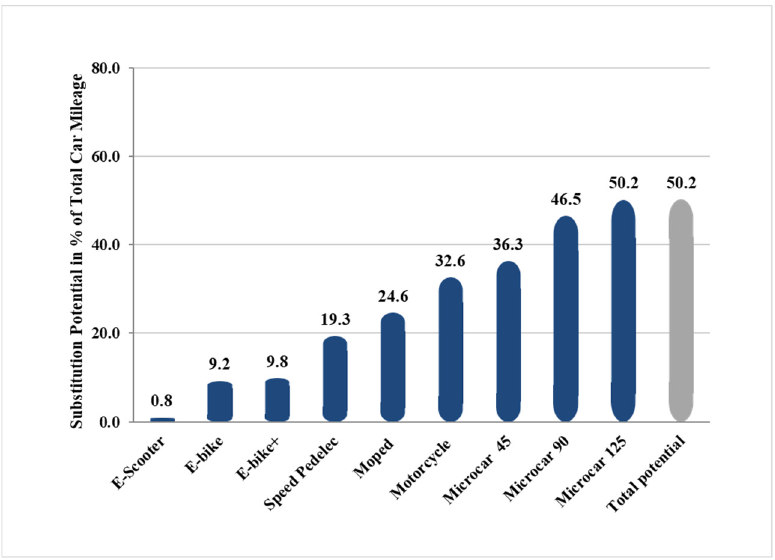
Figure 2. Maximum mileage substitution potential as a percentage of passenger car trips.